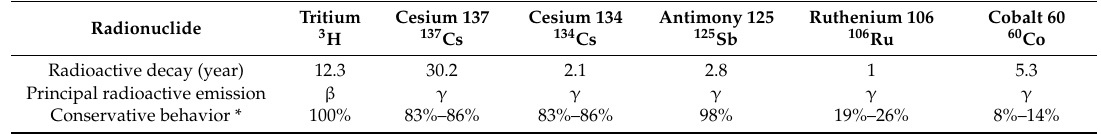
Table 1. Characteristics of the radionuclides used in this